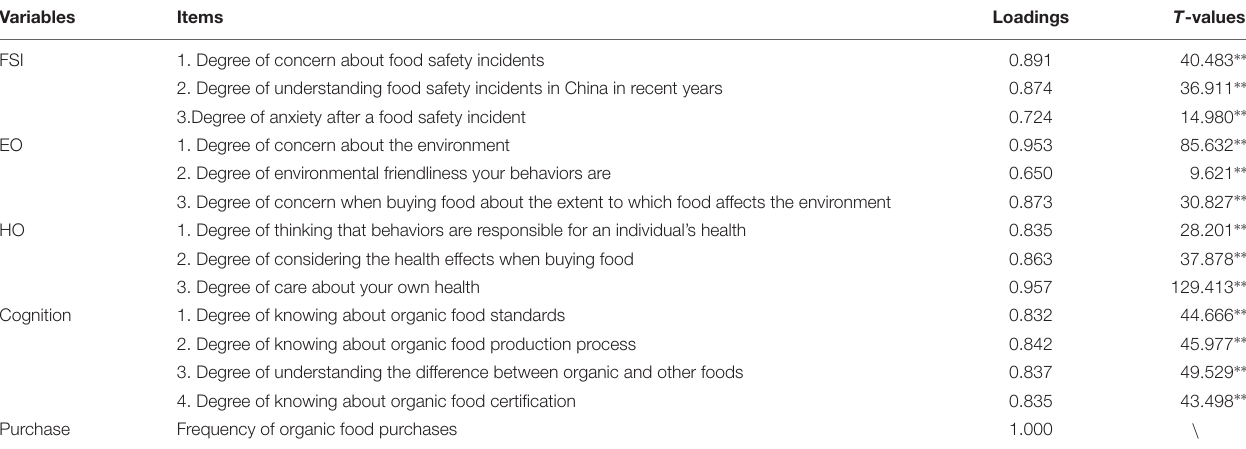
TABLE 2 | Loadings and T -values of reflective